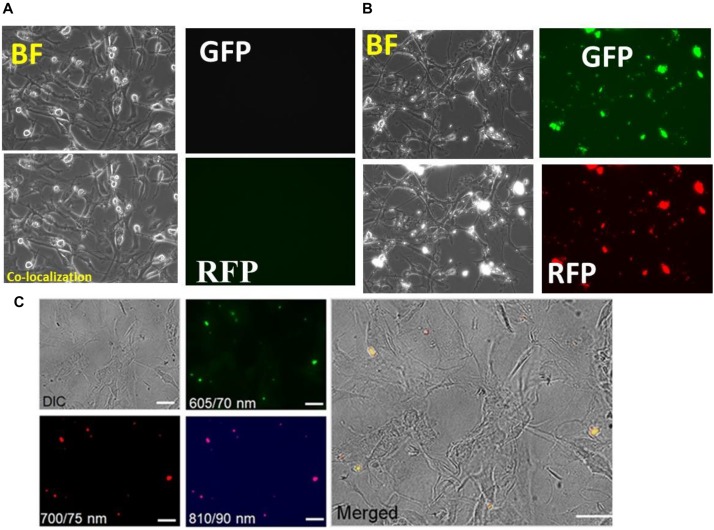
Toxicity profiles and co-localization of nanogels with astrocytes after 7 day treatment of nanogels. (A) Control; (B) 100 upmug/ml. (C) Cellular uptake analysis of the nanogels as assessed by the differential interference contrast (DIC) imaging and by the fluorescent imaging at the wavelength/bandwidth range of 605/70, 700/75, and 810/90 nm, scale – 20 μm. The merged image on the right panel shows the overlay of all the images.